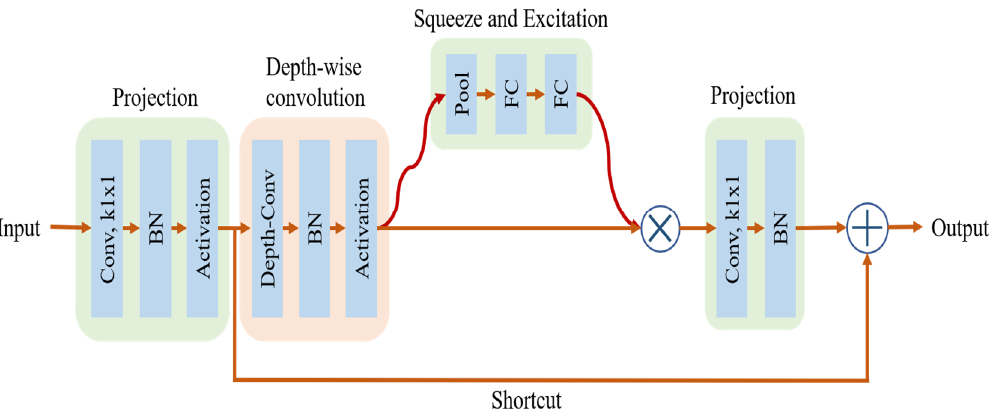
Figure 5. The main block of EfficientNet models, which is the mobile inverted bottleneck layer. (BN—Batch normalization layer, FC—Fully connected layer).